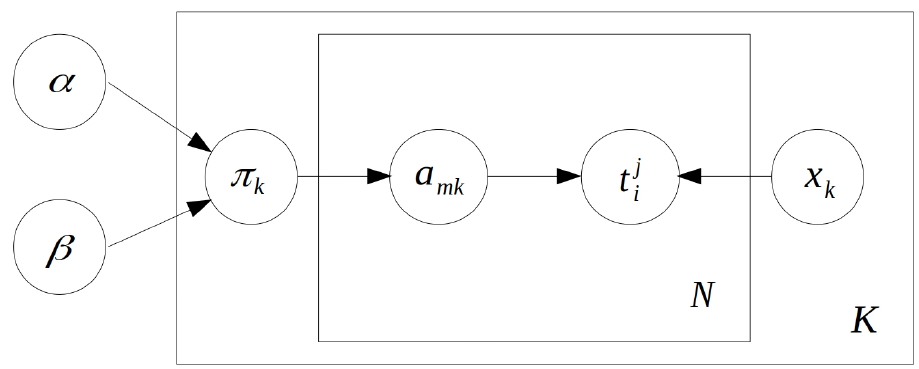
Figure 2. Graphical visualisation of the bistatic tracks association model. Parameters α and β define the Beta distributed (used in the definition of the IBP) hidden variables π k for a matrix of K columns. Association matrix entries a mk define the association between bistatic tracks t i we denote the overall number of bistatic tracks available.